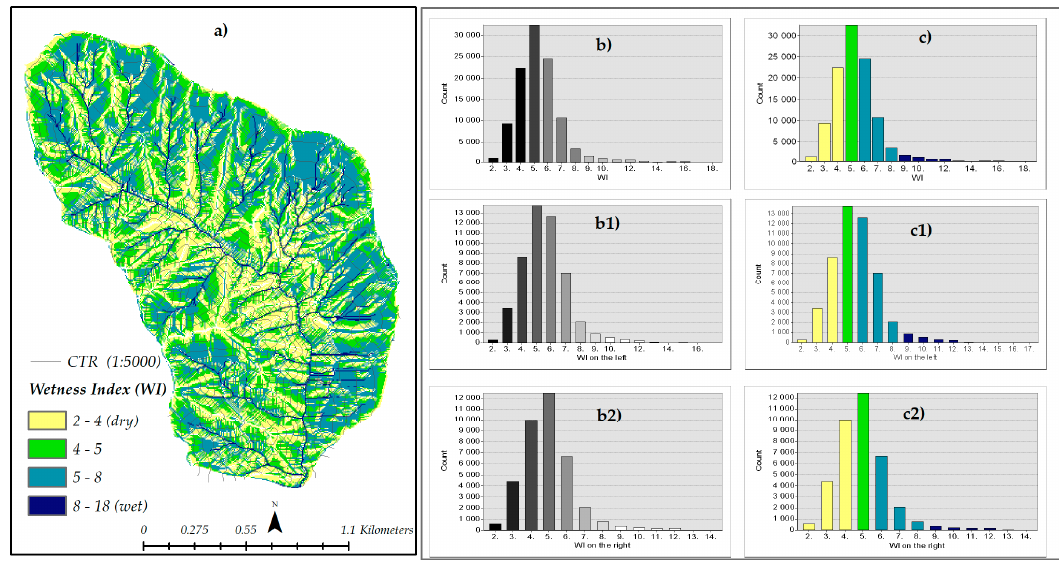
Figure 9. Classified Wetness Index (WI) map of the Ciciriello catchment ( a ), frequency distribution on the un-classified WI map on the whole catchment ( b ), on the left ( b1 ) and right side of it ( b2 ). Frequency distribution of the classified WI map performed on the whole catchment ( c ), on the left ( c1 ) and right side of the catchment ( c2 ). Appl. Sci. 2020 , 10 , x FOR PEER REVIEW